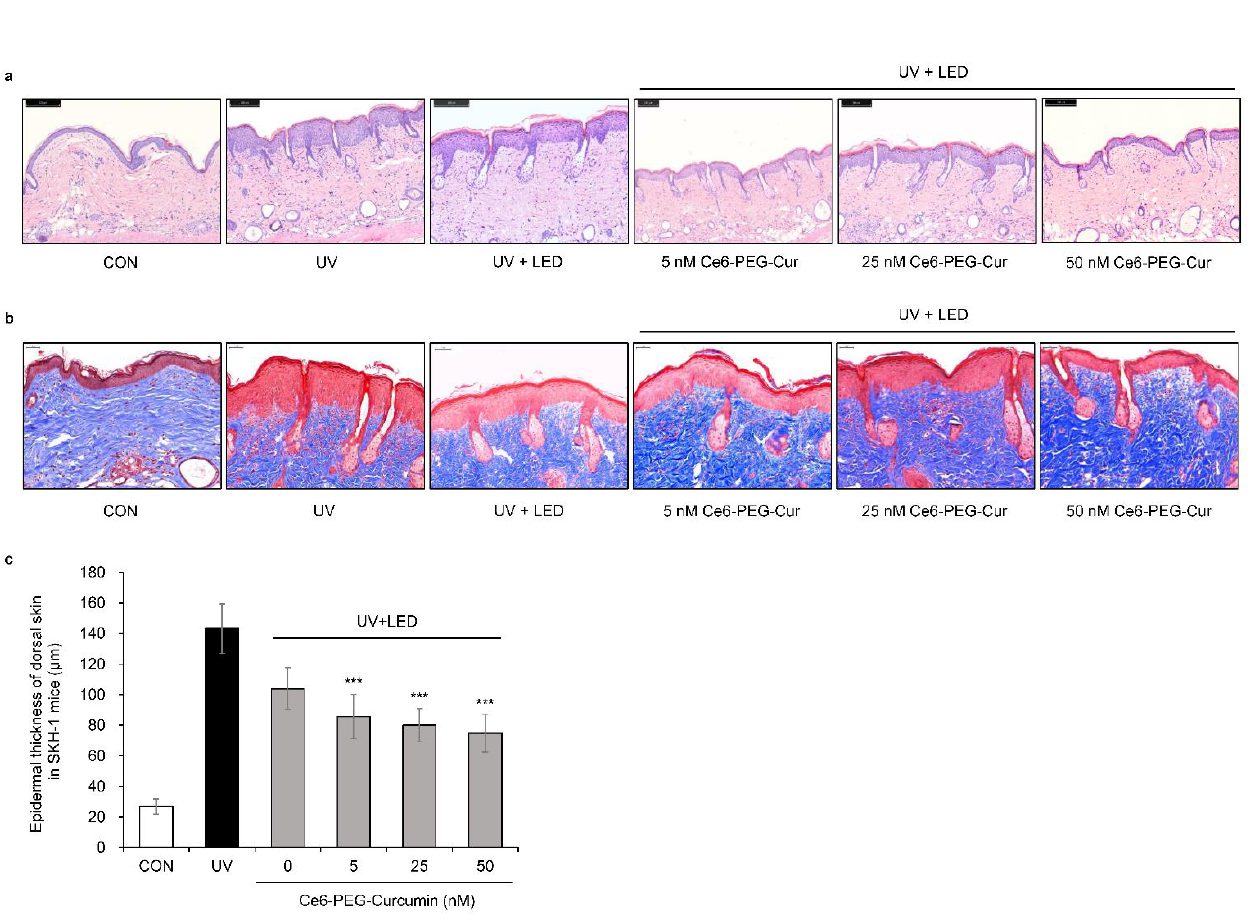
Figure 9. The effect of Ce6-PEG-curcumin-mediated PDT on the epidermal thickness and density of collagen fibers in the dorsal skin of UVB-irradiated mice. ( a ) H&E staining. Scale bar = 200 μm. ( b ) Masson’s trichrome staining. Scale bar = 50 μm. ( c ) Histogram of hematoxylin and eosin staining. Results are expressed as mean ± SD (n = 5). *** p < 0.001 vs. UVB-irradiated control.